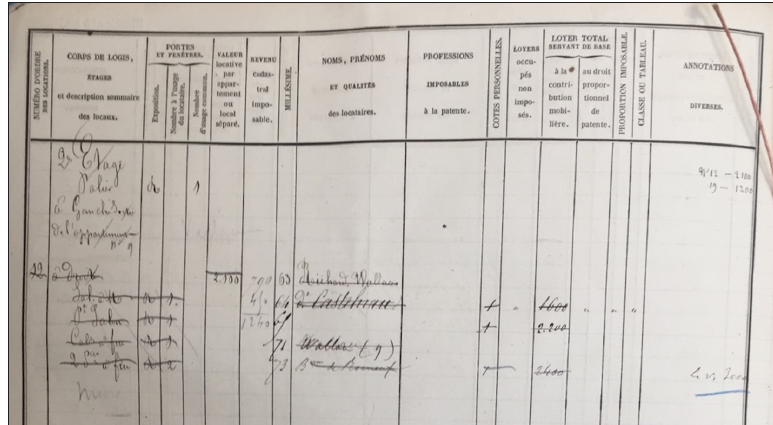
Fig. 3 : Document recording Richard Wallace as the leaseholder of an apartment on the second floor of 1–3 rue Taitbout in 1863 and Dame Castelnau as the leaseholder of the same apartment in 1864. Archives de Paris, Calepin des propriétés bâties